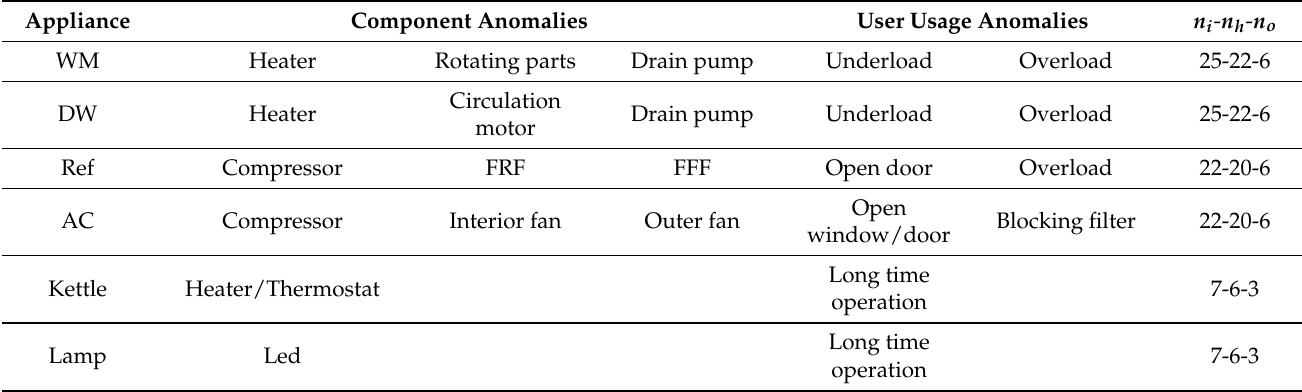
Table 1. Anomaly types and the ANN configurations of some